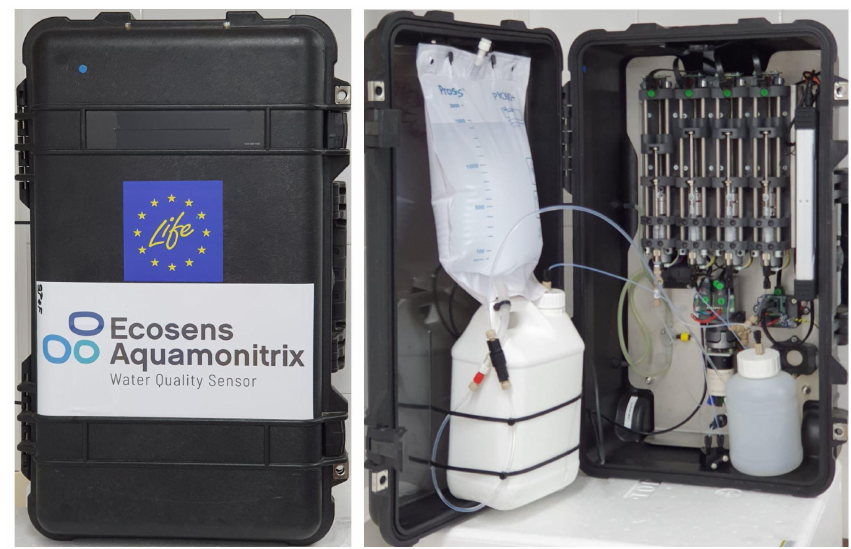
Figure 7. Outer and inner view of an integrated IoT sensor for water quality monitoring applications. The sensor consists of a nitrite and nitrate analyzer based on a novel ion chromatography method, used for detection of toxic substances [112].